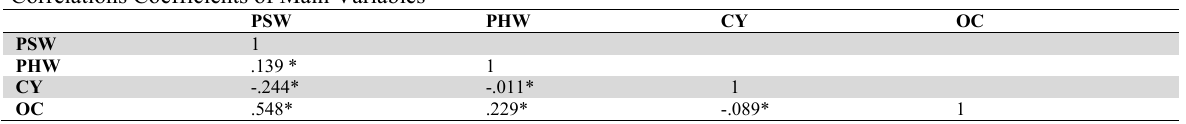
Correlations Coefficients of Main Variables